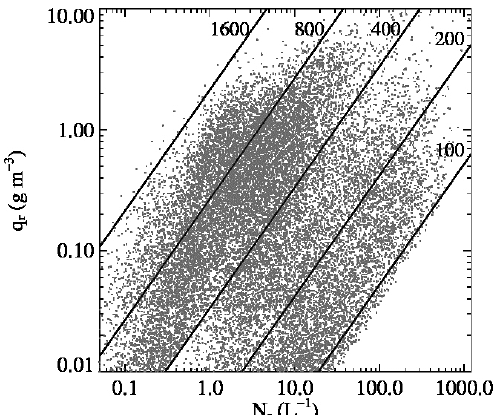
Figure 3. Scatterplot of the drop number concentration, N r , and the rainwater content, q r , for drop spectra sampled at 1Hz. Lines rep- resent constant mean volume diameters for D v = 1600, 800, 400, 200,